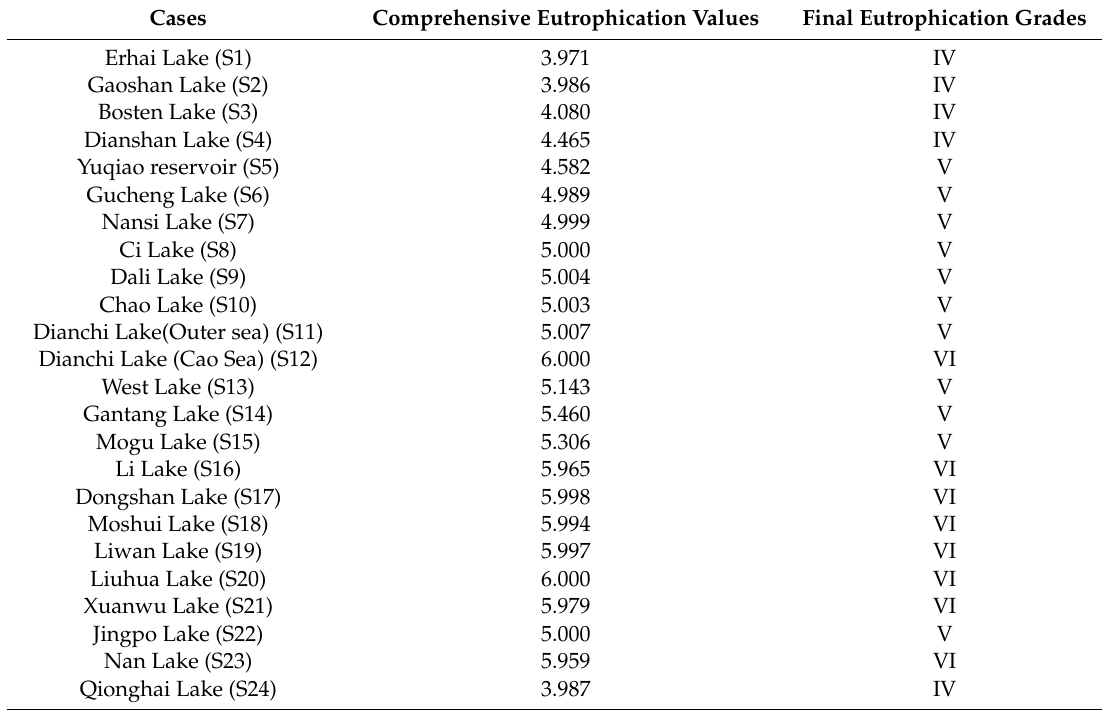
Table 8. Comprehensive eutrophication values of